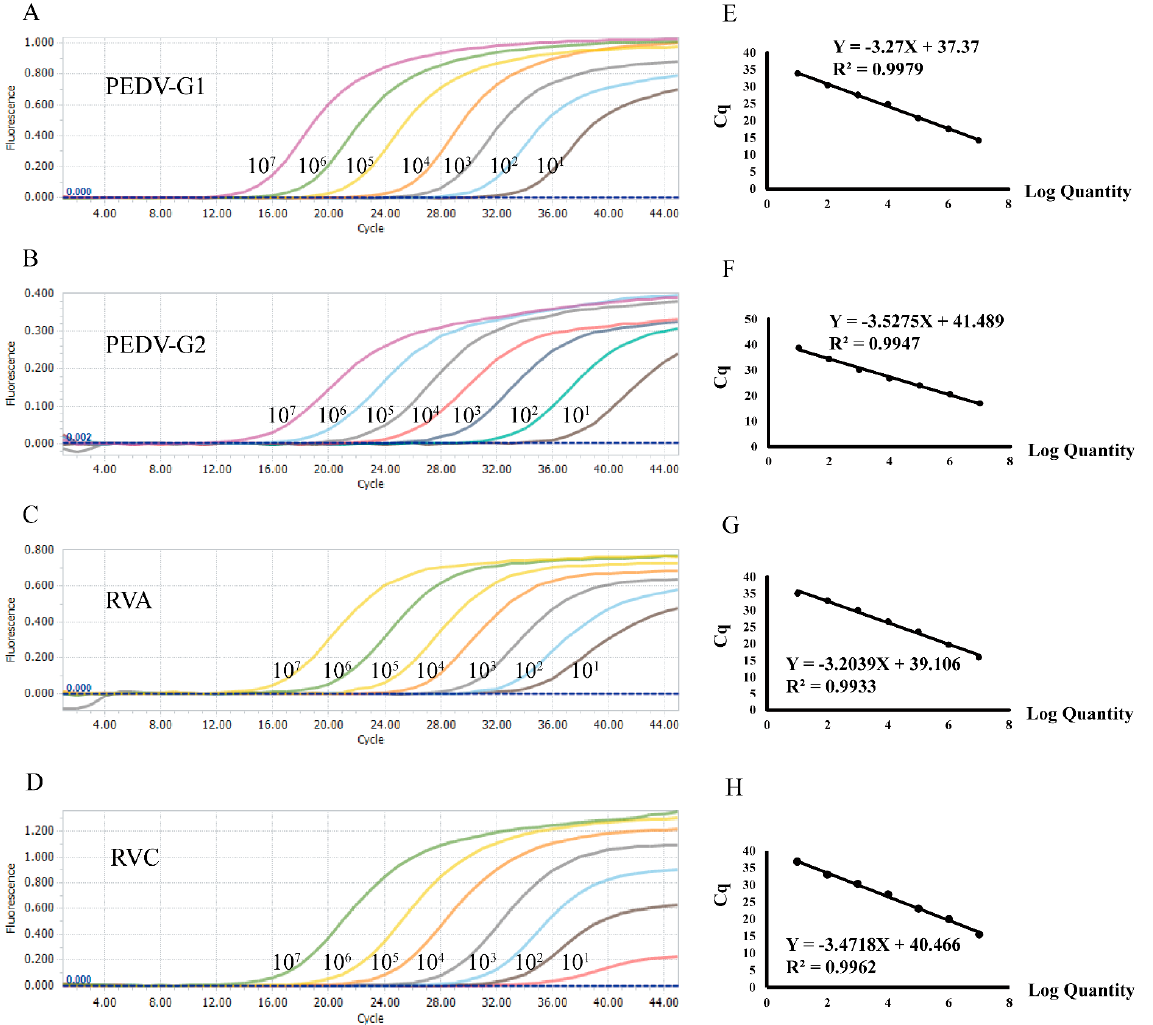
Figure 1. Preparation of the plasmid standards. ( A – D ) amplification curves (X-axis: cycle, Y-axis: fluorescence) of PEDV genotypes G1 and G2, and porcine groups A and C of the rotavirus for each plasmid standard with concentrations from 1 × 10 7 copies/ µ L to 1 × 10 1 copies/ µ L. ( E – H ) standard curves of the plasmid standards of PEDV genotypes G1 and G2, and porcine groups A and C of the